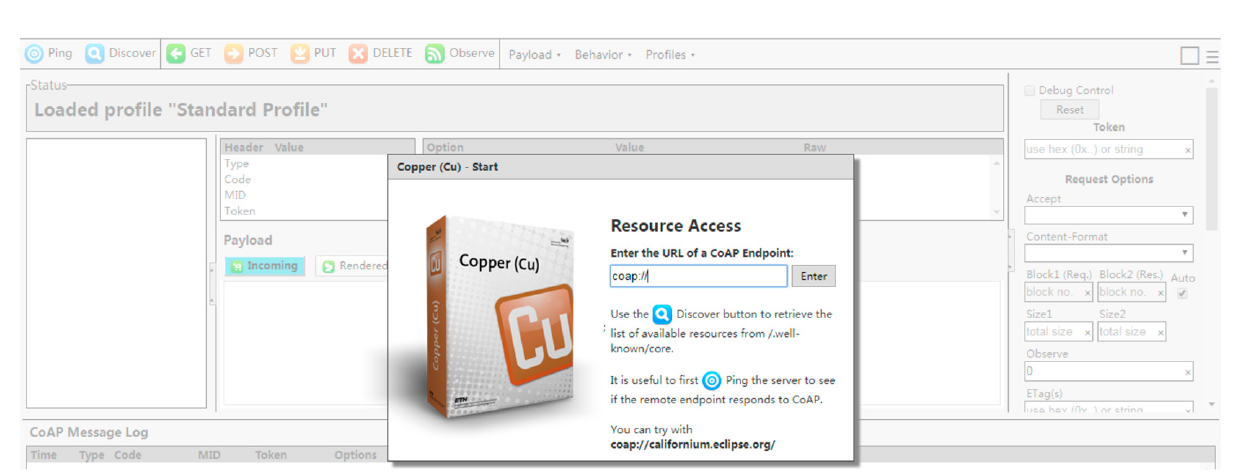
Figure 20. The Copper client environment used for testing CoAP messages.